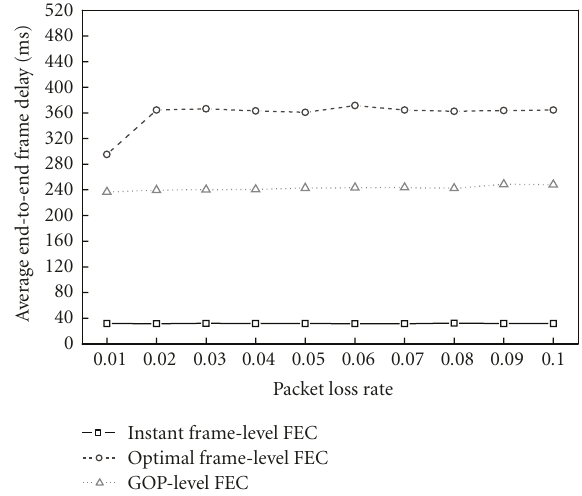
Figure 13: Comparison of end-to-end frame delays with varied packet loss rate.